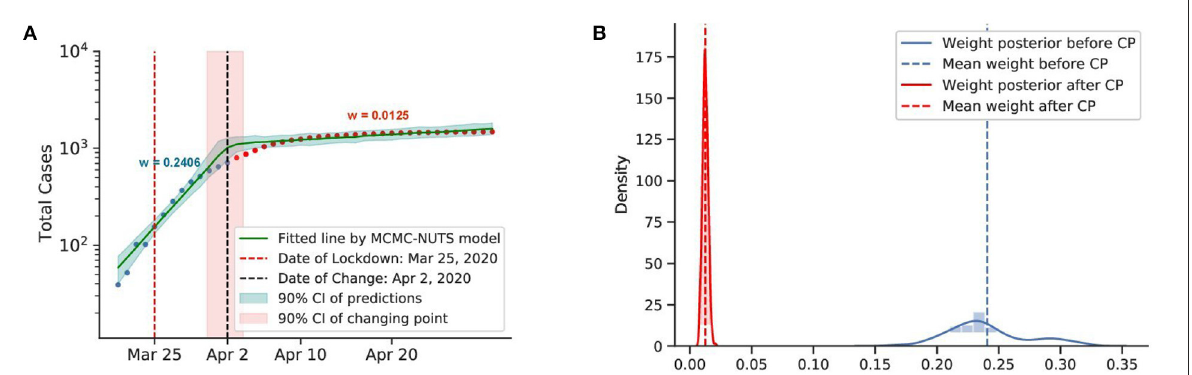
FIGURE6 Posterior for New Zealand. After confirming the first case, New Zealand experienced a rapid spread of the diseases. The government imposed a strong lockdown from March 25, 2020 (71) and brought the outbreak under control in February, 2020. The growth rate declined from 0.2406 to 0.0125. The change-point was around April 2, 2020. (A) Fitted graph for New Zealand with change-point on April 2, 2020. (B) Posterior distribution of weights (transmission rate) before and after change-point.